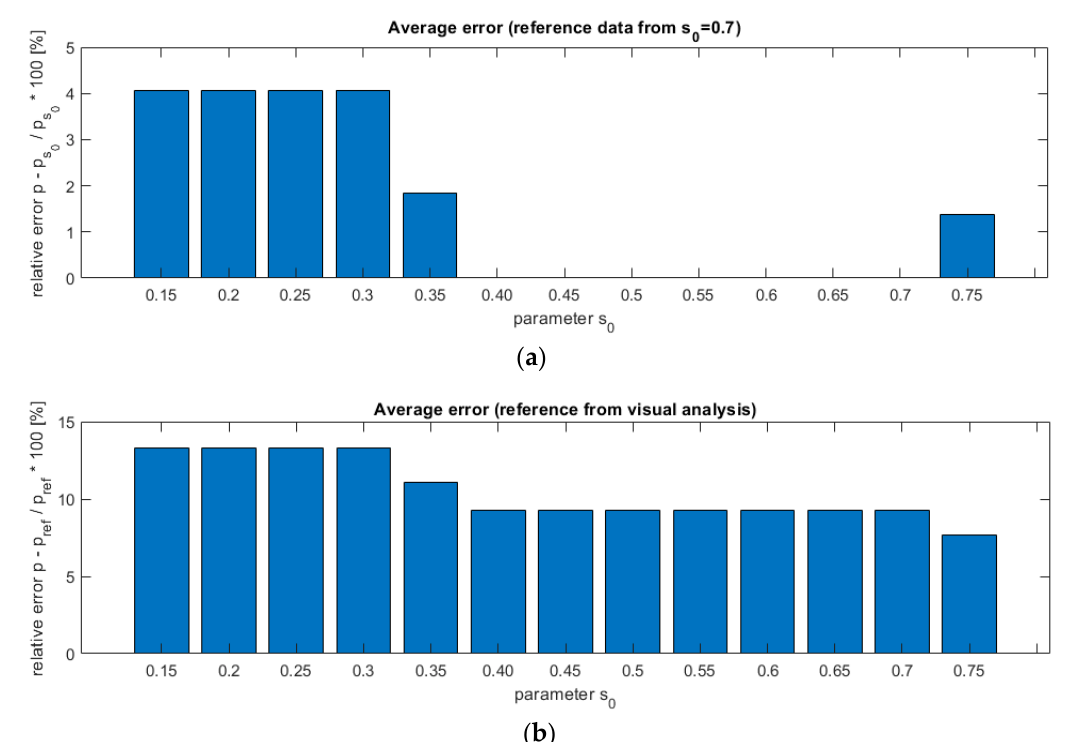
Figure 10. Plug identification algorithm threshold value impact on the velocity estimation accuracy. The plot on the top ( a ) shows the relative error for s 0 = 0.7 as a reference (expected value). The relative error based on the visual analysis as a reference is shown beneath ( b ).